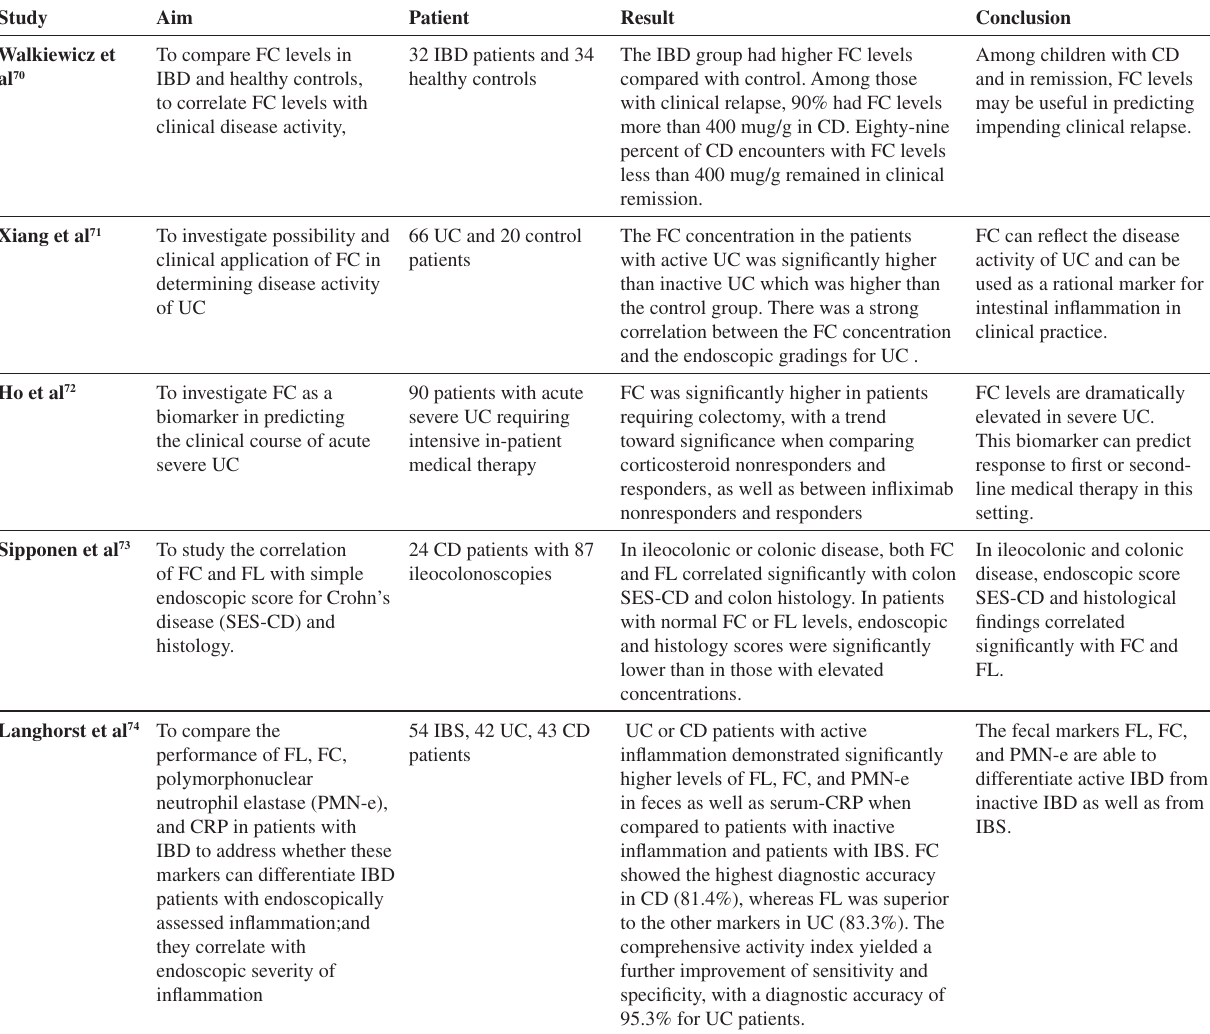
Table 1 - Some recent studies about the fecal markers in the evaluation of IBD